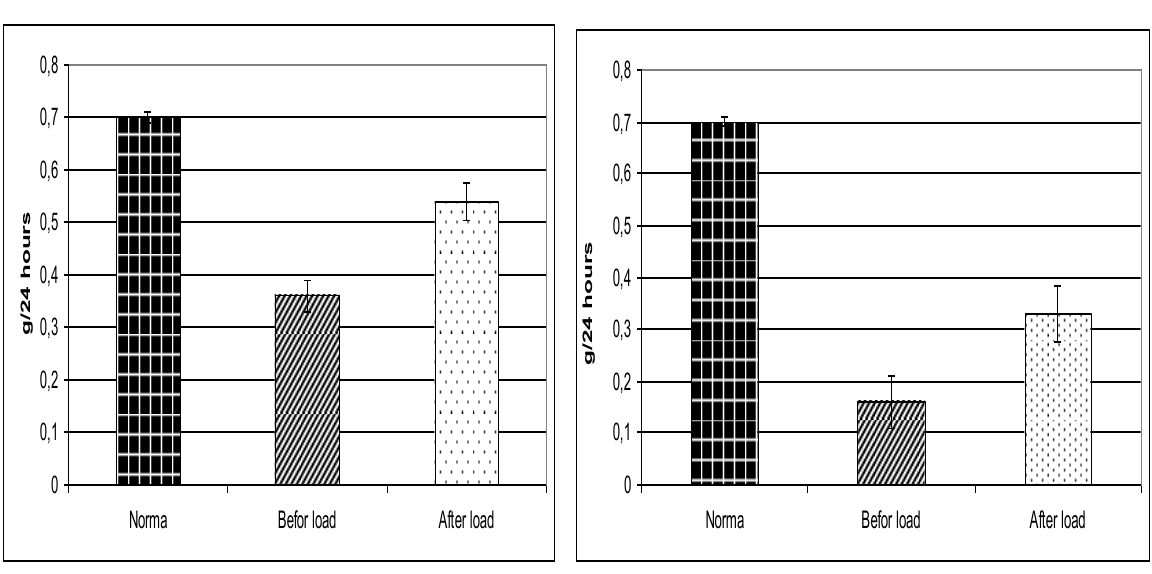
А B Fig.1. Creatinine excretion of 13 years football players at the beginning (А) and at the end (B) of competition period After football match quantity of creatinine in urina also increases up to 0.33 g/24 hours (р<0.05), but this value still is significantly less than at the beginning of competition period. Analysis of the received data shows that during all competition period quantity of creatinine in urinal is less than it is required by standard. At the beginning of competition period quantity of creatinine before match was lower by 49%, and at the end of competition period it reduced by 77 %. After football match quantity of creatinine in urina was also decreased during competition season: at the beginning of competition period – by 23%, and at the end – by 53%. Thus, the above rendered data of bio-chemical tests point at progressing of tiredness and not complete recreation of junior football players.. Tiredness also is witnessed by absence of positive dynamic in shortening of time of distances 15 and 30 meters’ covering at the end of competition period.